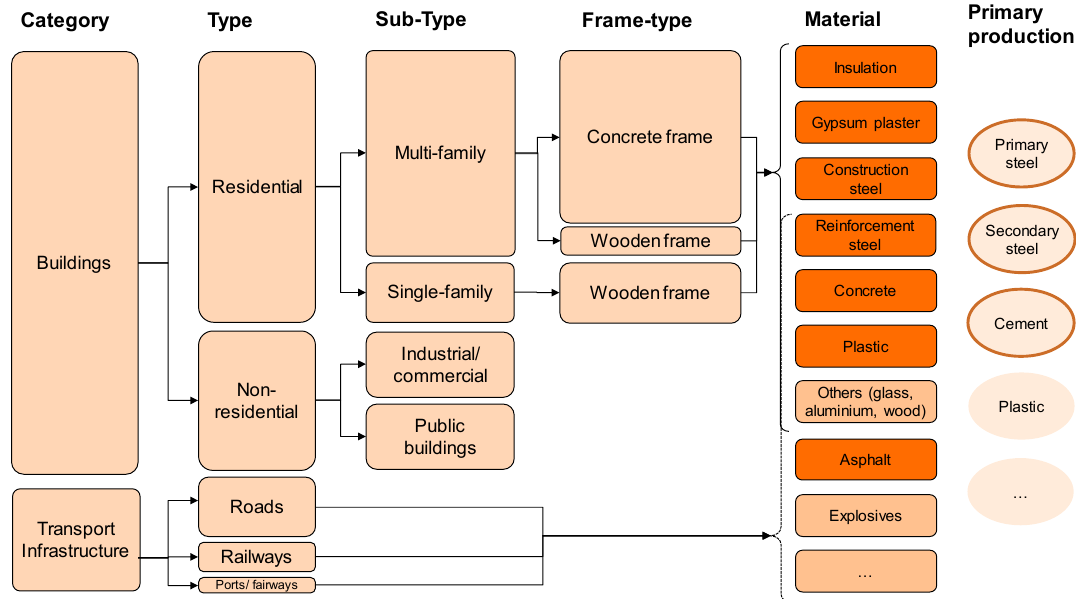
Figure 1. Schematic figure of material flow mapping for buildings and transport infrastructure construction in Sweden. The height of the category to frame-type boxes represent the approximate relative sizes of the associated emissions. Regarding materials, the dark orange boxes depict materials studied in detail, while the dark orange contours in the primary production column depict material production processes evaluated in detail. The analysis also includes emissions from mass and material transport and construction processes.